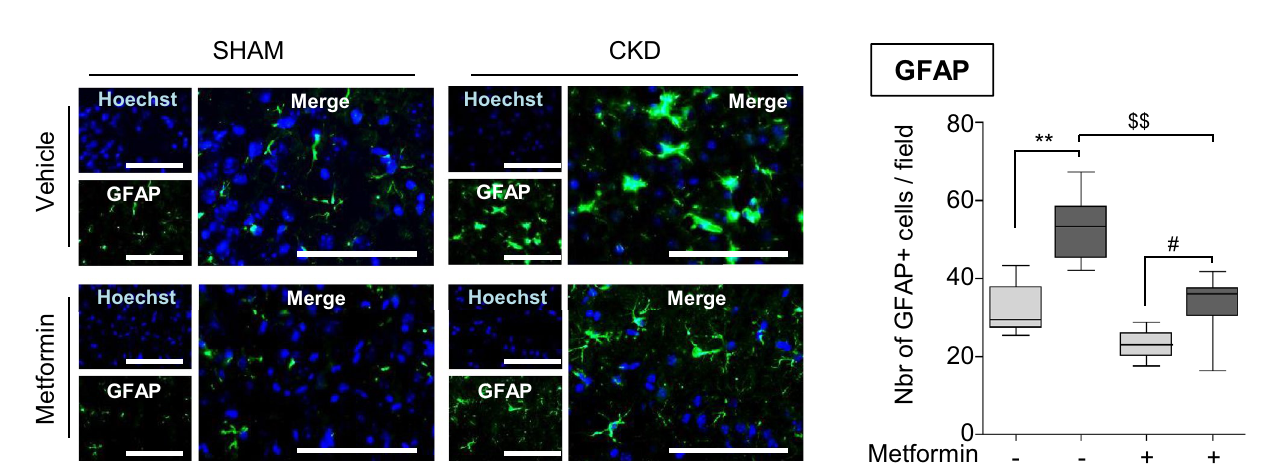
Figure 5. Metformin pre-conditioning decreases astrogliosis in the ischemic penumbra of CKD mice. Immunostaining analysis of GFAP expression (a marker of astrocytes) in the cortex of SHAM and CKD mice exposed, or not, to metformin. Scale bars: 100 µm. Quantifications show the number of GFAP positive cells per 10,000-µm 2 field. Results are expressed as the median, interquartile, and min–max and show data from at least 8 animals per group. Statistical analysis was performed using a non-parametric Kruskall–Wallis test followed by Dunn’s multiple comparison post-hoc test. **p < 0.01, CKD-vehicle vs. SHAM-vehicle mice. # p < 0.05, CKD- metformin vs. SHAM-metformin mice. $$ p < 0.01, CKD-metformin vs. CKD-vehicle mice.